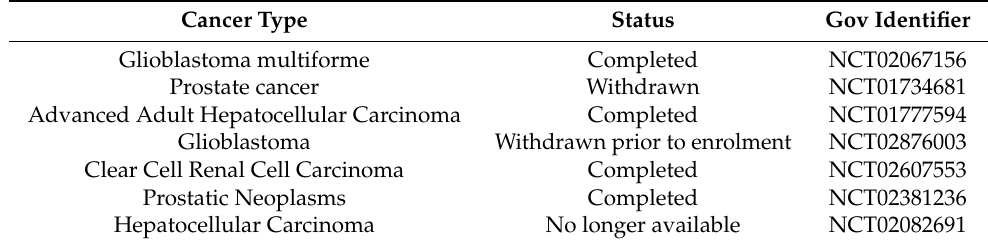
Table 2. Phase II clinical trials of